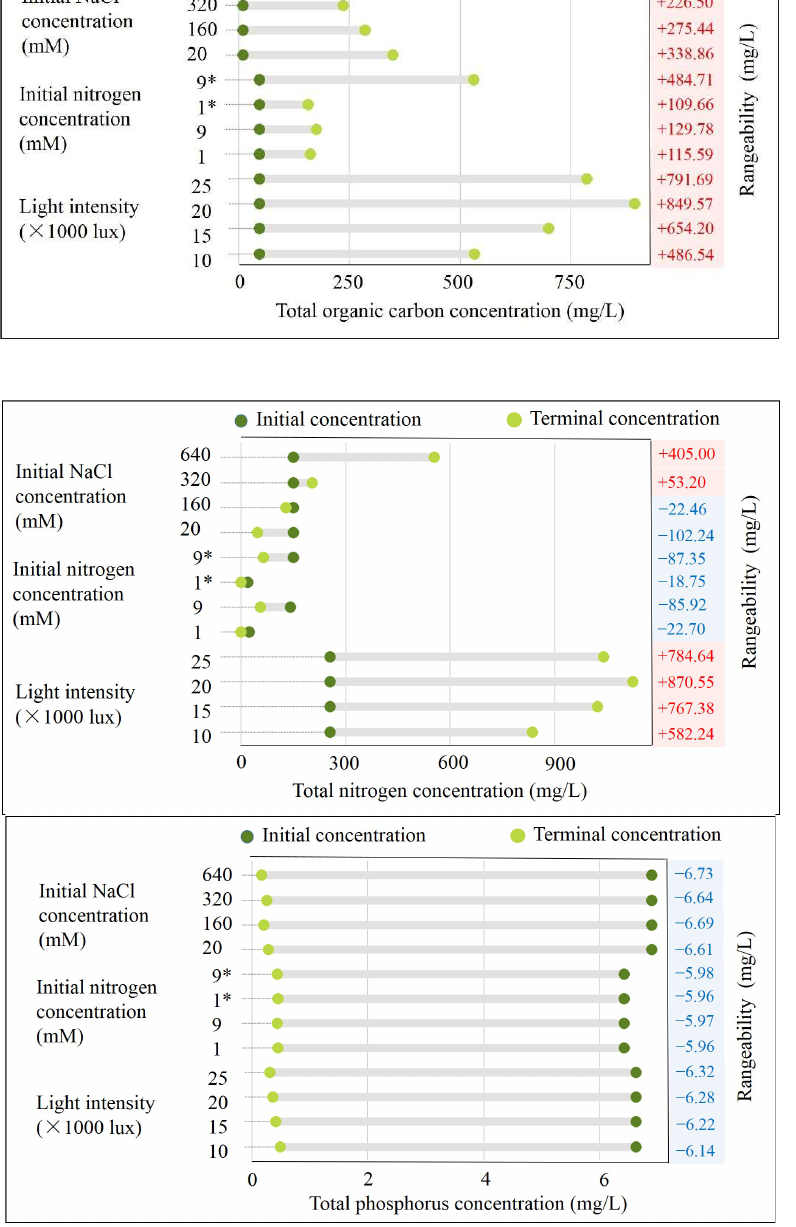
Figure 4. The residue concentrations of total organic carbon, total nitrogen, and total phosphorus were exposed to different culture conditions. In the initial nitrogen concentration group, 1 and 9 represent 1 mM and 9 mM initial nitrogen concentrations under the 10,000 lux, and 1* and 9* represent 1 mM and 9 mM initial nitrogen concentrations under the 25,000 lux.